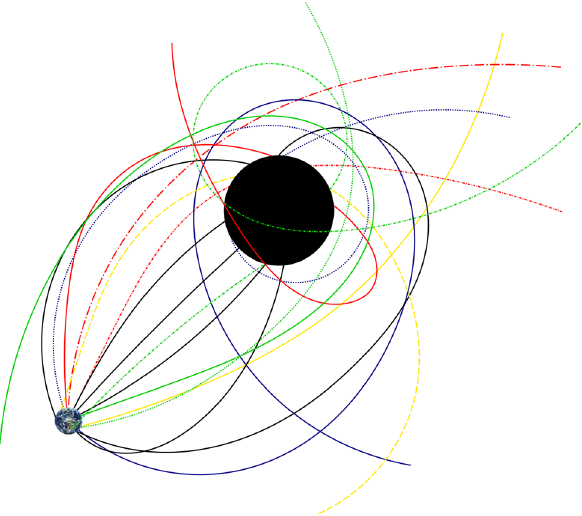
Fig. 1 Graphic representation of the backward ray tracing: the Earth is the observer from which the photons are emitted, and the black sphere plays the role of a black hole. The lines represent null geodesics, among which are those that are trapped by gravitational attraction (black lines) and those that escape to infinity (colored lines)